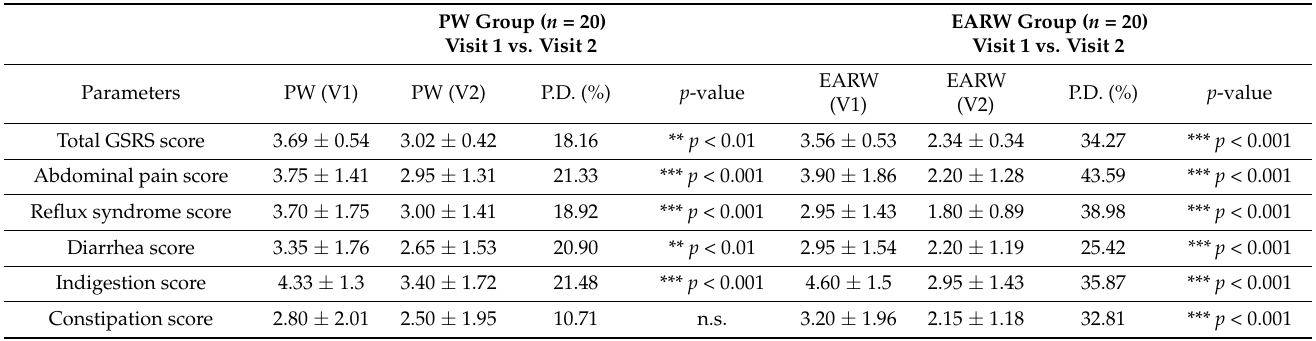
Table 3. Drinking effects of EARW assessed by GSRS in FD patients.